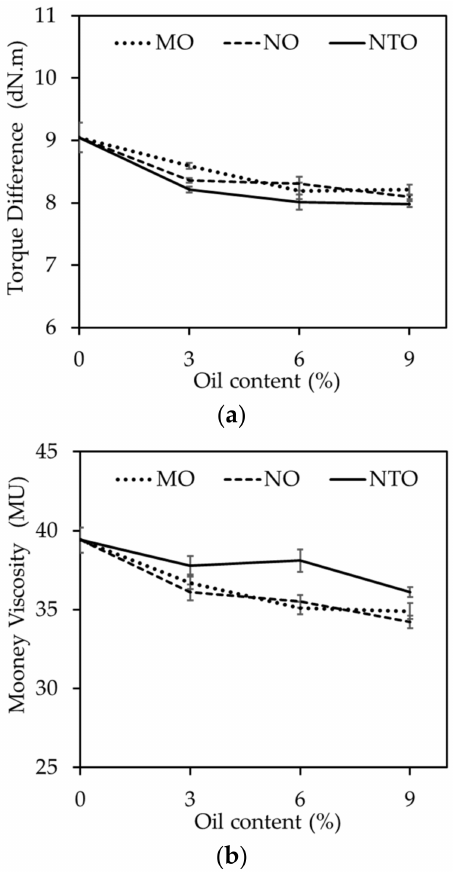
Figure 3. ( a ) Torque difference and ( b ) Mooney viscosities of the rubber compounds comprising different oil types and